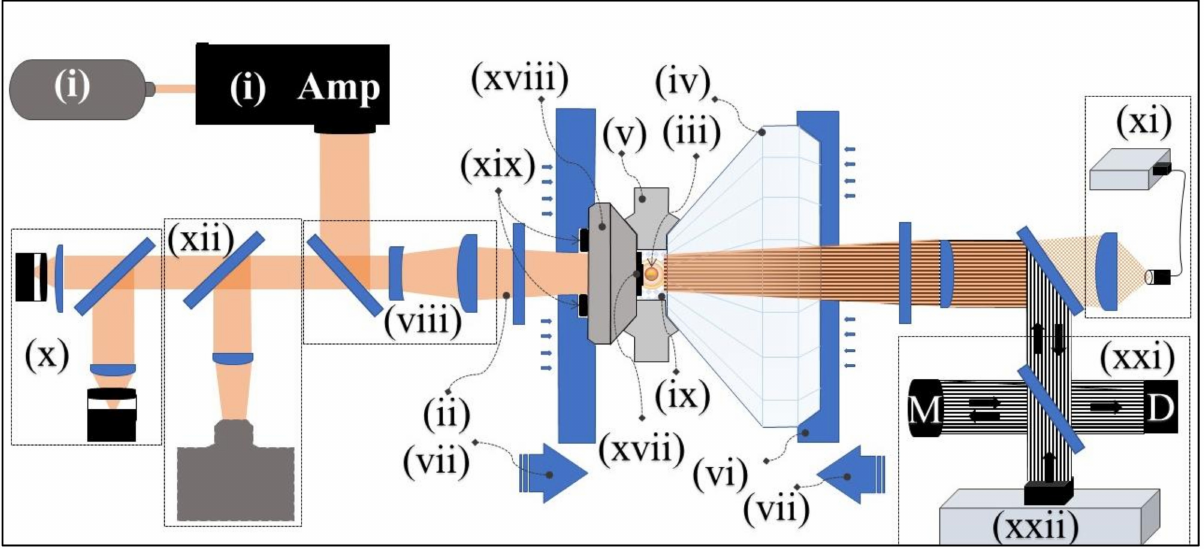
Figure 4. Typical arrangement of laser-driven dynamic compression diamond anvil cells (LDC– DAC), systems for scientific/engineering experiments. The various components of these systems are described in the